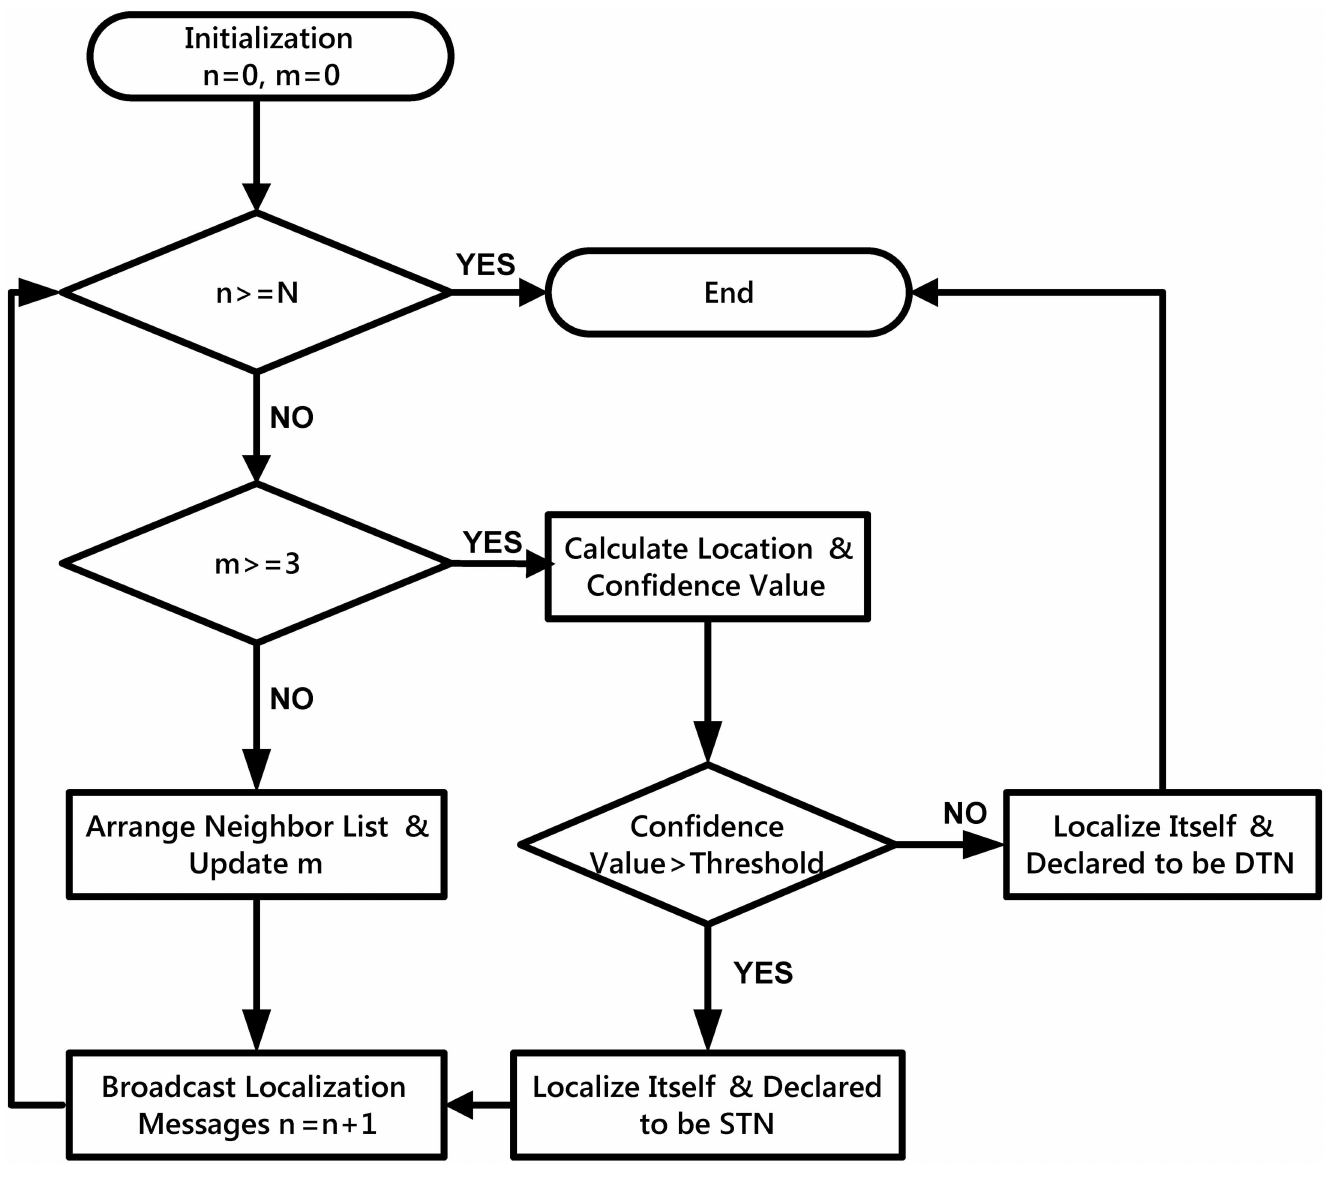
Fig 3. Nodes localization in